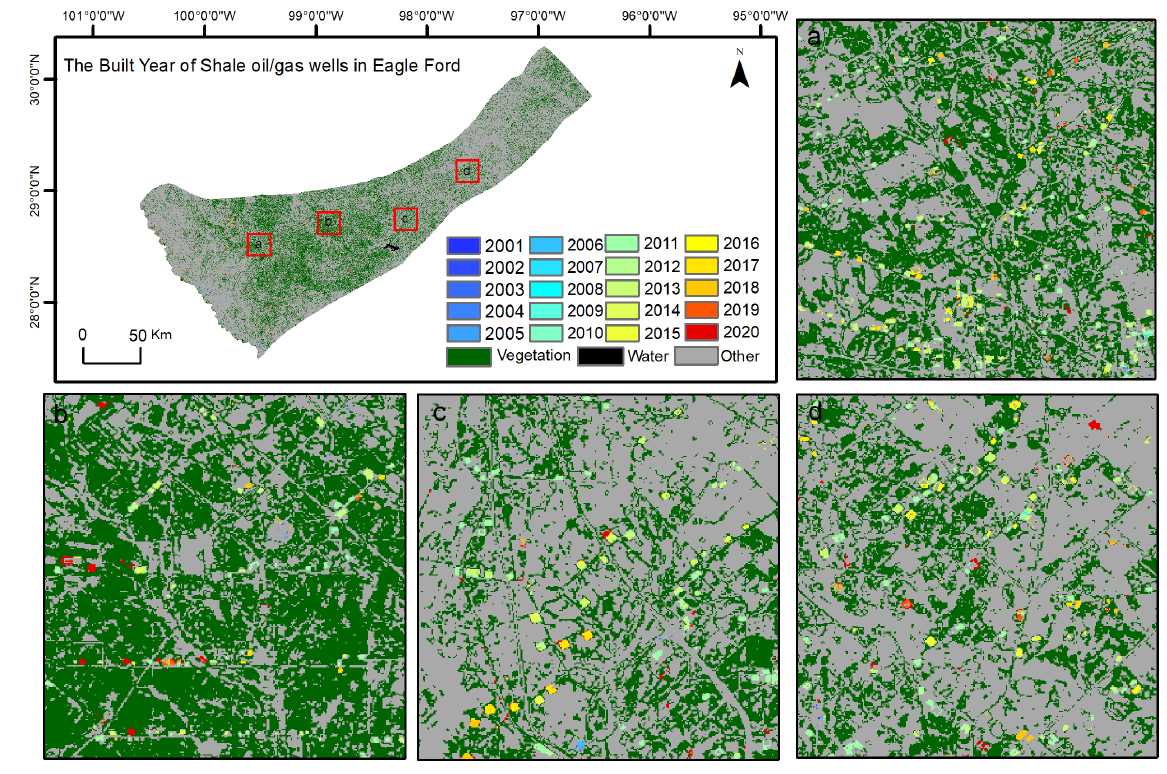
Figure 8. Disturbance map of shale gas wells built in Eagle Ford from 2000 to 2020.